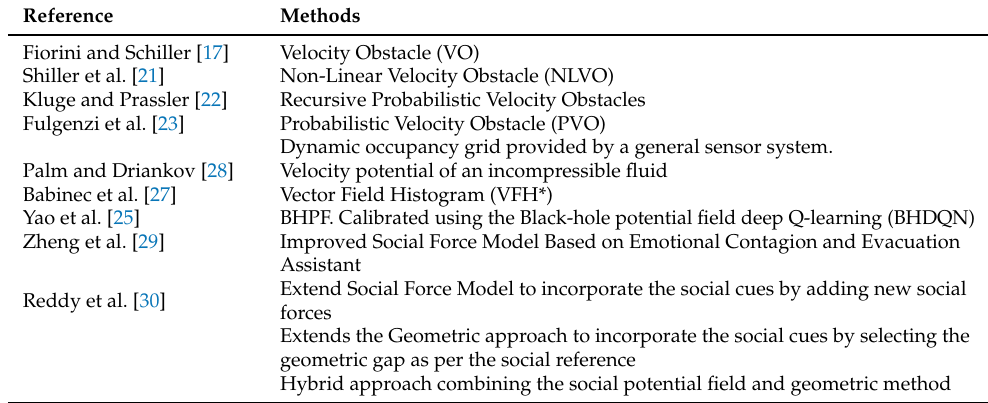
Table 1. Approaches considered in Section 3.1. The table covers the methods they use for solving the local navigation